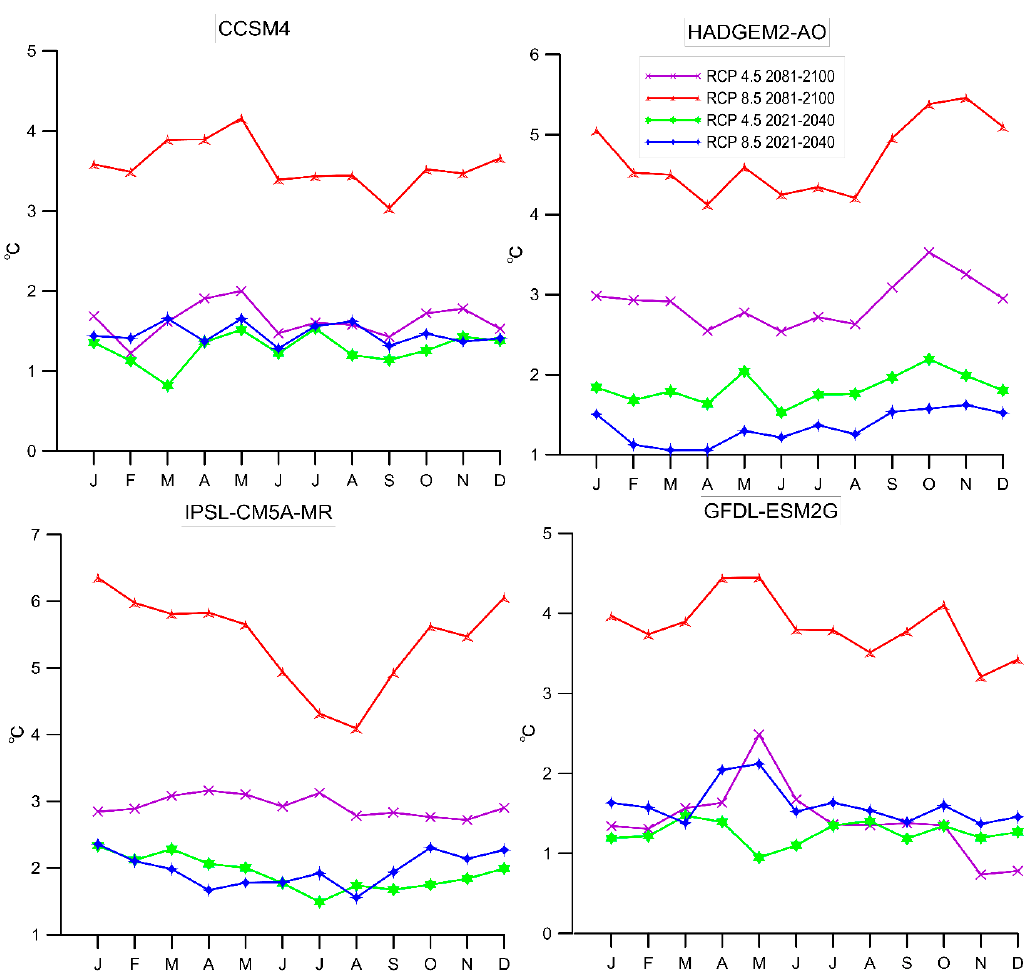
Figure 3. Projected change in mean temperature at Gilgel Abbay watershed for 2021–2040 and 2081–2100 time windows under RCP 8.5 and RCP 4.5 (Representative Concentration Pathway, 4.5 and 8.5 are used for medium–low and high emission scenarios,